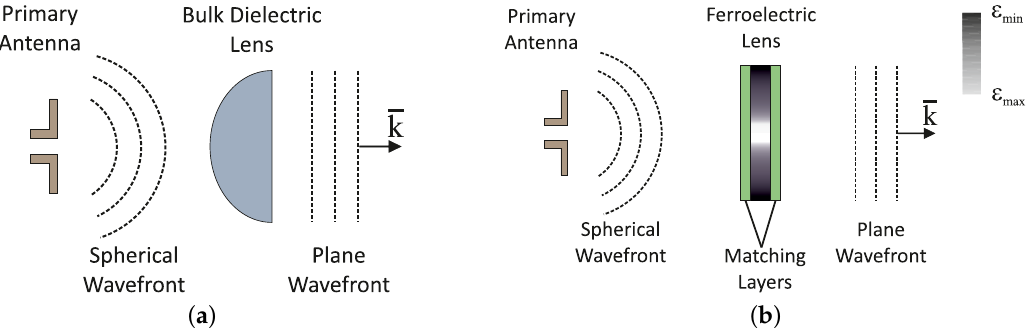
Figure 1. Comparison of ( a ) the linear dielectric lens and ( b ) the electrically tunable FE